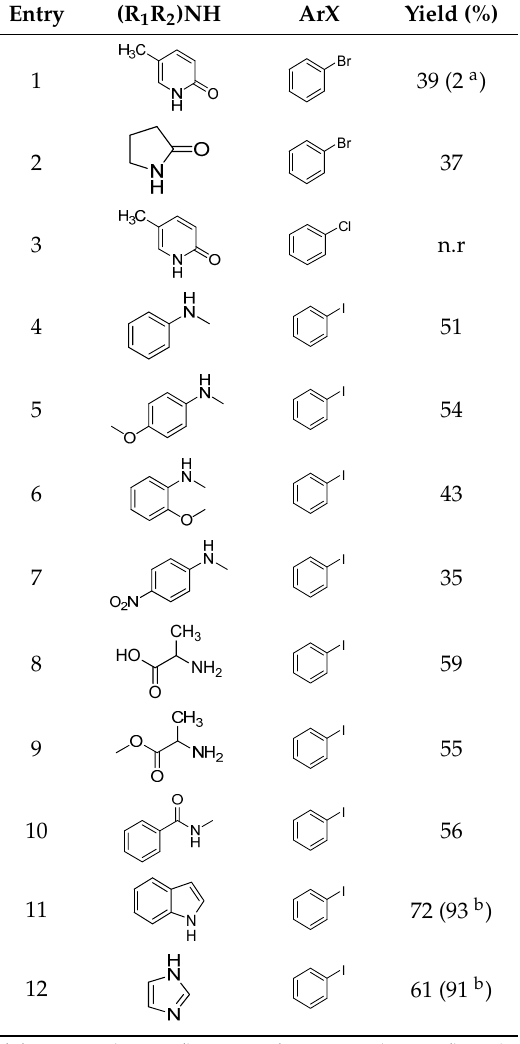
Molecules 2015 , 20 , page–page Molecules 2015 , 20 , page–page Table 2. Ullmann and Goldberg type C–N coupling reactions of halobenzenes with various amines Table 2. Ullmann and Goldberg type C–N coupling reactions of halobenzenes with various amines Table 2. Ullmann and Goldberg type C–N coupling reactions of halobenzenes with various amines Table 2. Ullmann and Goldberg type C–N coupling reactions of halobenzenes with various amines and amides over Cu-TDPAT *. Table 2. Ullmann and Goldberg type C–N coupling reactions of halobenzenes with various amines Table 2. Ullmann and Goldberg type C–N coupling reactions of halobenzenes with various amines Table 2. Ullmann and Goldberg type C–N coupling reactions of halobenzenes with various amines Table 2. Ullmann and Goldberg type C–N coupling reactions of halobenzenes with various amines and amides over Cu-TDPAT *. and amides over Cu-TDPAT *. Table 2. Ullmann and Goldberg type C–N coupling reactions of halobenzenes with various amines and amides over Cu-TDPAT *. Table 2. Ullmann and Goldberg type C–N coupling reactions of halobenzenes with various amines Molecules 2015 , 20 , page–page and amides over Cu-TDPAT *. and amides over Cu-TDPAT *. Table 2. Ullmann and Goldberg type C–N coupling reactions of halobenzenes with various amines and amides over Cu-TDPAT *. and amides over Cu-TDPAT *. Table 2. Ullmann and Goldberg type C–N coupling reactions of halobenzenes with various amines and amides over Cu-TDPAT *. Table 2. Ullmann and Goldberg type C–N coupling reactions of halobenzenes with various amines and amides over Cu-TDPAT *. Table 2. Ullmann and Goldberg type C–N coupling reactions of halobenzenes with various amines Table 2. Ullmann and Goldberg type C–N coupling reactions of halobenzenes with various amines and amides over Cu-TDPAT *. Table 2. Ullmann and Goldberg type C–N coupling reactions of halobenzenes with various amines and amides over Cu-TDPAT *. Table 2. Ullmann and Goldberg type C–N coupling reactions of halobenzenes with various amines and amides over Cu-TDPAT *. Table 2. Ullmann and Goldberg type C–N coupling reactions of halobenzenes with various amines and amides over Cu-TDPAT *. and amides over Cu-TDPAT *. and amides over Cu-TDPAT *. and amides over Cu-TDPAT *. Molecules 2015 , 20 , page–page and amides over Cu-TDPAT *. Table 2. Ullmann and Goldberg type C–N coupling reactions of halobenzenes with various amines and amides over Cu-TDPAT *. Table 2. Ullmann and Goldberg type C–N coupling reactions of halobenzenes with various amines Molecules 2015 , 20 , page–page and amides over Cu-TDPAT *. Table 2. Ullmann and Goldberg type C–N coupling reactions of halobenzenes with various amines and amides over Cu-TDPAT *. Table 2. Ullmann and Goldberg type C–N coupling reactions of halobenzenes with various amines and amides over Cu-TDPAT *. Table 2. Ullmann and Goldberg type C–N coupling reactions of halobenzenes with various amines and amides over Cu-TDPAT *. Table 2. Ullmann and Goldberg type C–N coupling reactions of halobenzenes with various amines and amides over Cu-TDPAT *. Table 2. Ullmann and Goldberg type C–N coupling reactions of halobenzenes with various amines and amides over Cu-TDPAT